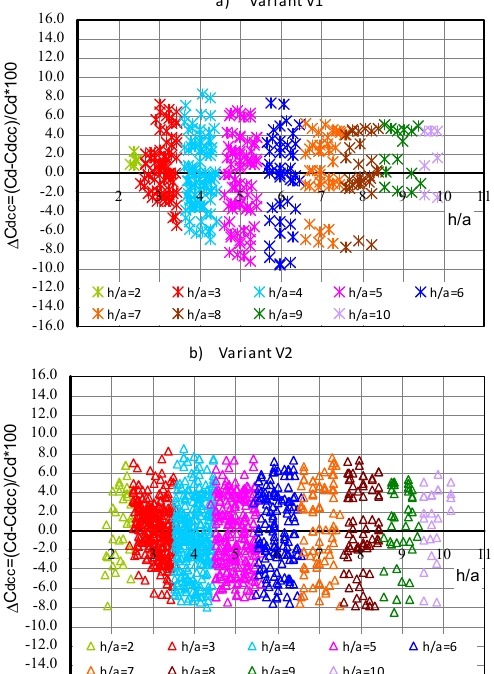
Figure12. Percentagedeviationinvaluesofdischargecoe ffi cientsobtainedonthebasisofmeasurements Figure 12. Percentage deviation in values of discharge coefficients obtained on the basis of C d and calculated with correction C dcc : ( a ) case V1, ( b ) case V2. measurements C d and calculated with correction C dcc : ( a ) case V1, ( b ) case V2. As previously stated, the percentage deviations of the discharge coefficients determined from the C d measurements and relationship (5) given by Swamee [15] C dc are in the range of ( − 5÷40)% (Figure 10). The values of the C dcc discharge coefficients calculated from Equation (5) with the correction Δ C dcc differ from the discharge coefficients C d obtained from measurements by ± 9% (Figure 12) The discharge coefficients obtained from the measurements and calculated using relationship (5) with correction (13-14) for both cases are shown in Figure 13.